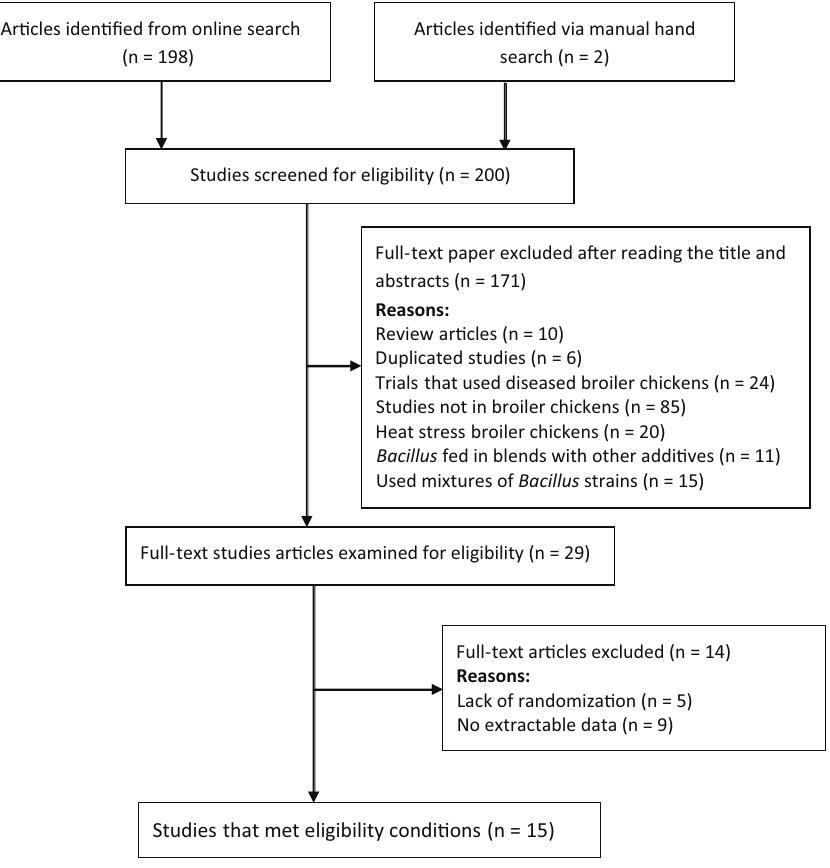
Figure 1: Flow diagram of the paper selection process used for the